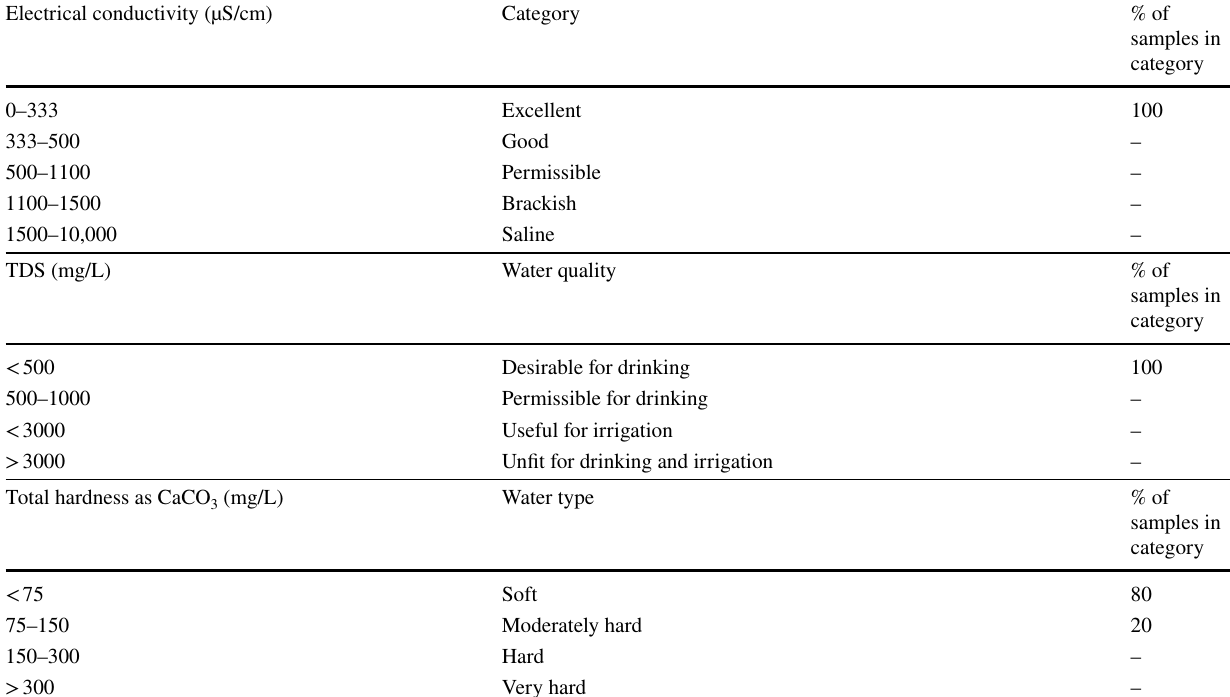
Table 3 Classification of water resources based on EC (Langenegger 1990), TDS (Davis and De Wiest 1966) and TH (Sawyer and McCa-